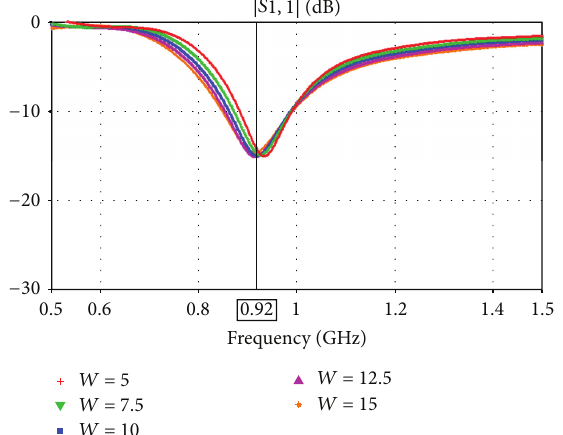
Figure 9: Resonance frequency of single-layer strip dipole antenna with difference width (millimeters).